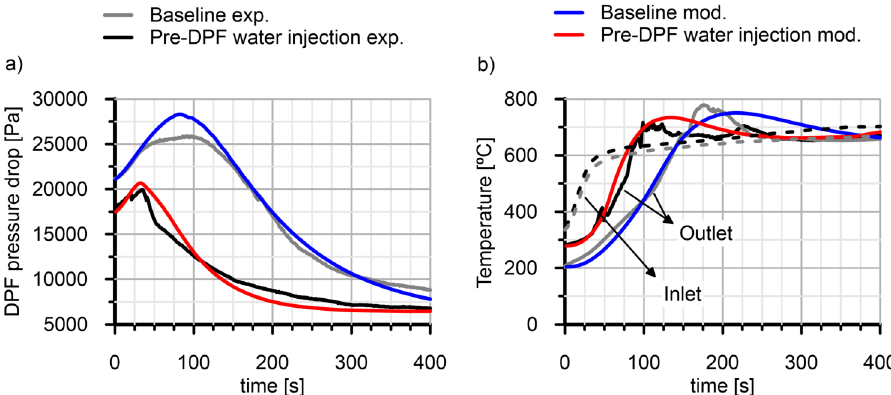
Figure 14. Caption can be rewritten as: Comparison between experimental and modeled ( a ) DPF